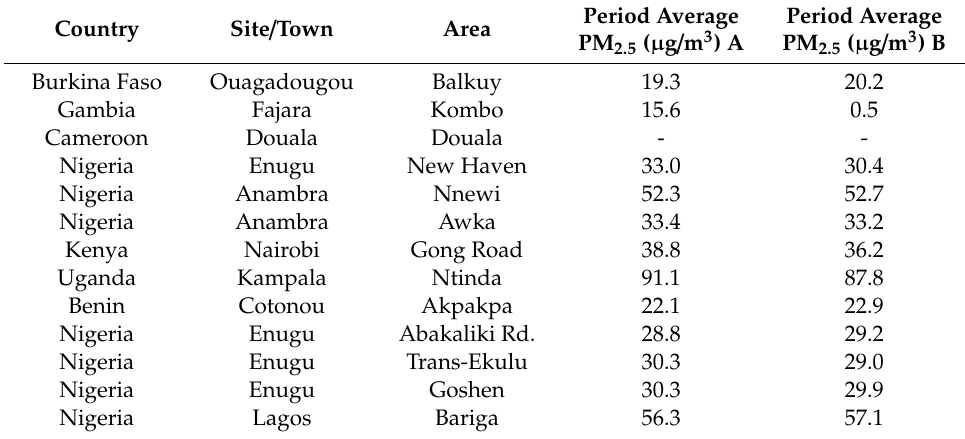
Table 4. Level of Internal Agreement between Purple Air Sensors A and B at Each MA3